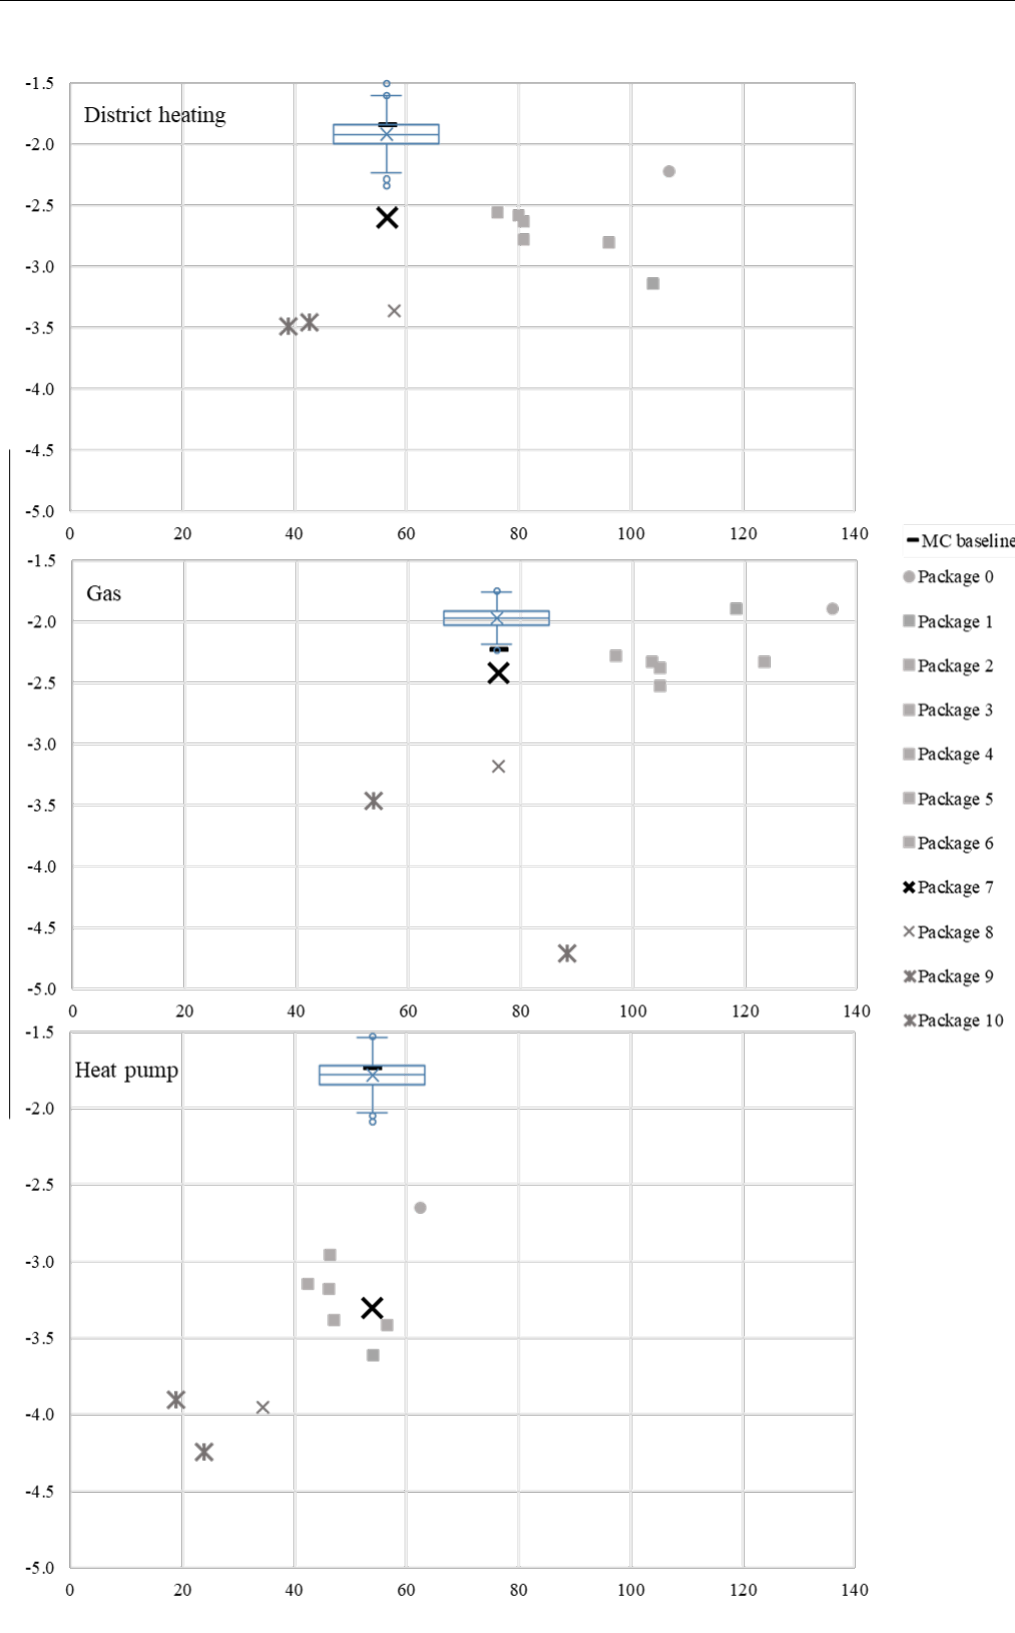
Figure 9. Robustness analyses of the cost-effective baseline (Package 7), compared to cost-optimality results for renovation packages adapted from [28]. Box plot depicts results from Monte Carlo (MC) variation for three energy supply systems.